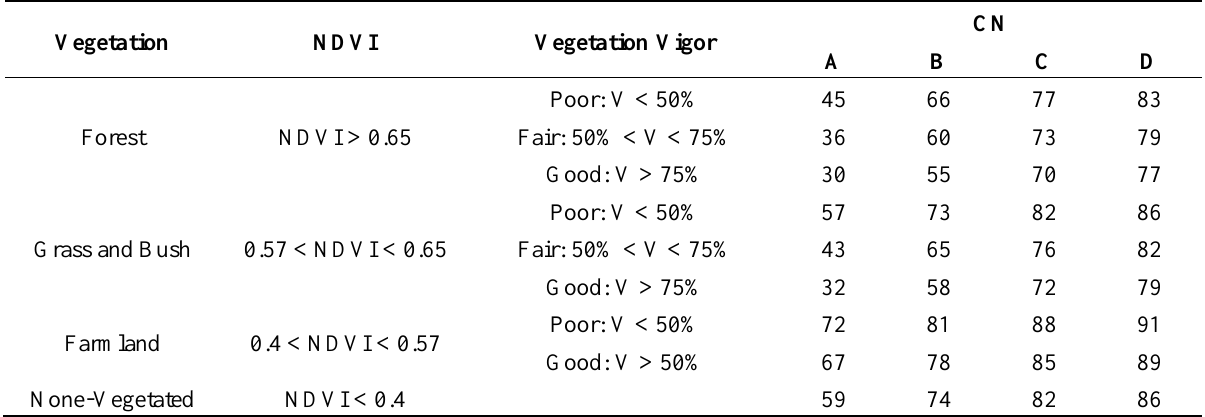
Table 2. Initial Values of CN